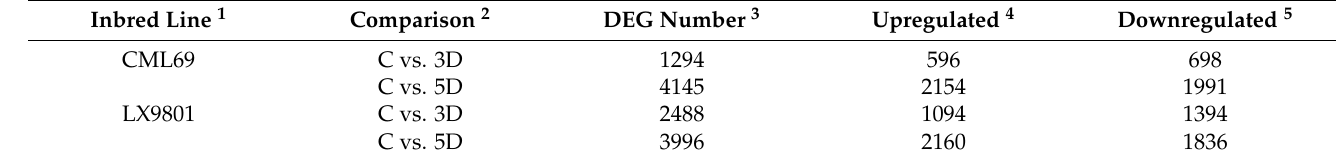
Table 2. Expression patterns of the 6906 annotated DEGs by inbred line and drought stress stage. Inbred Line